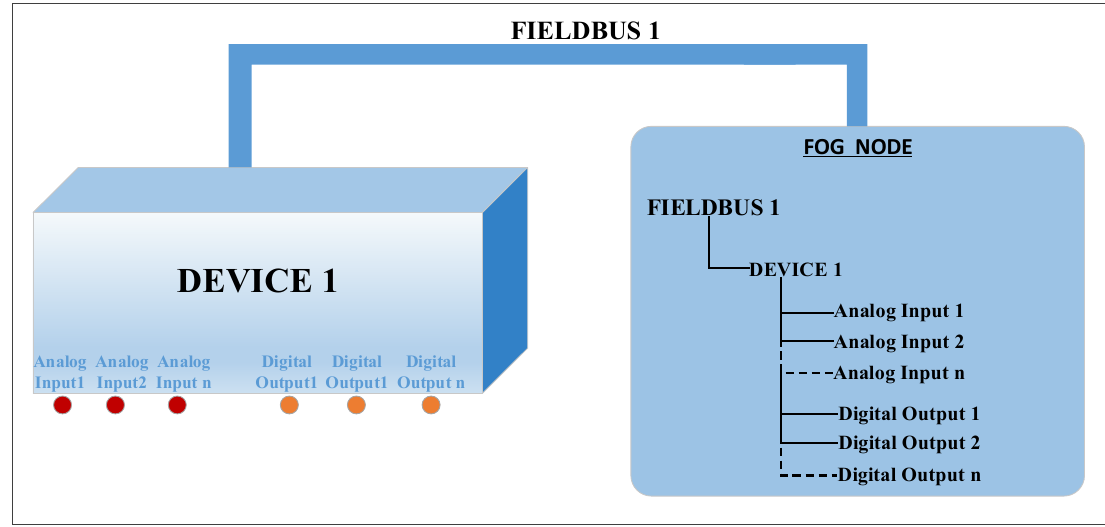
Figure 4. Example of the address space for a device with n analog inputs and n digital outputs.